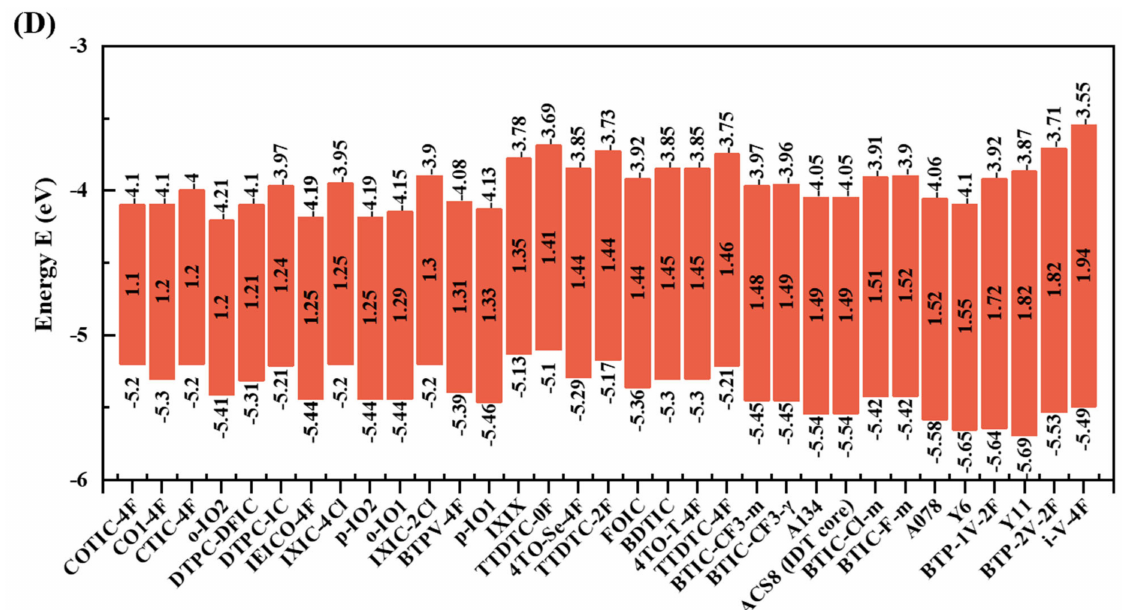
Figure 2. ( A ) PCE of OPVs in dependance on the band gap of the donor materials. ( B ) PCE of OPVs in dependance on the band gap of the acceptor materials. ( C ) Energy levels of donors, sorted by ascending band gap and labeled consistently with abbreviation in original publication. ( D ) Energy levels of acceptors, sorted by ascending band gap and labeled consistently with abbreviation in original